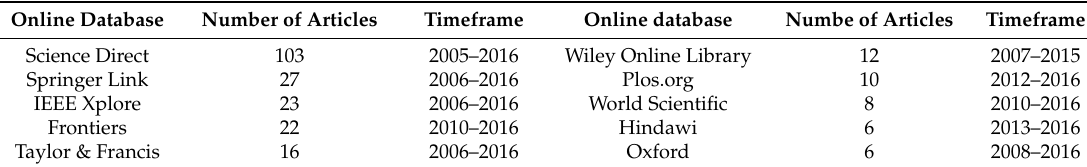
Table A2. Classification of articles based on the online database.